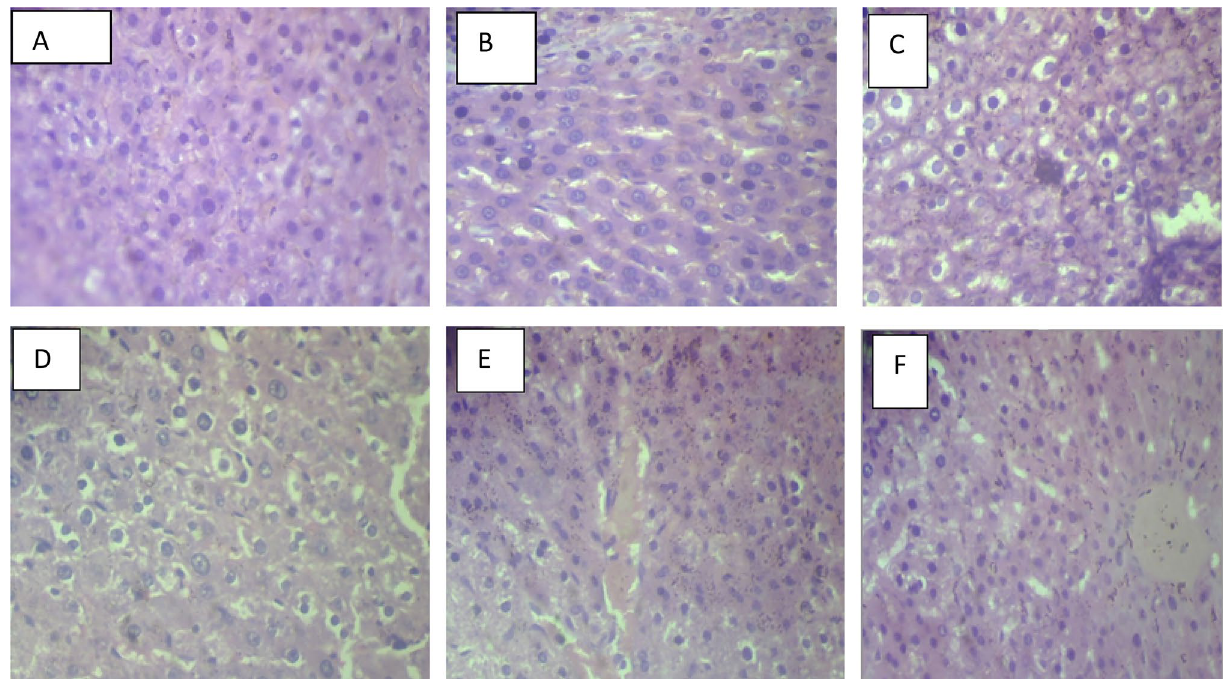
Fig. 6 Effect of SNPs and PEG treated water on histopathological sections of liver in rats. Hematoxylin and eosin stain at × 100